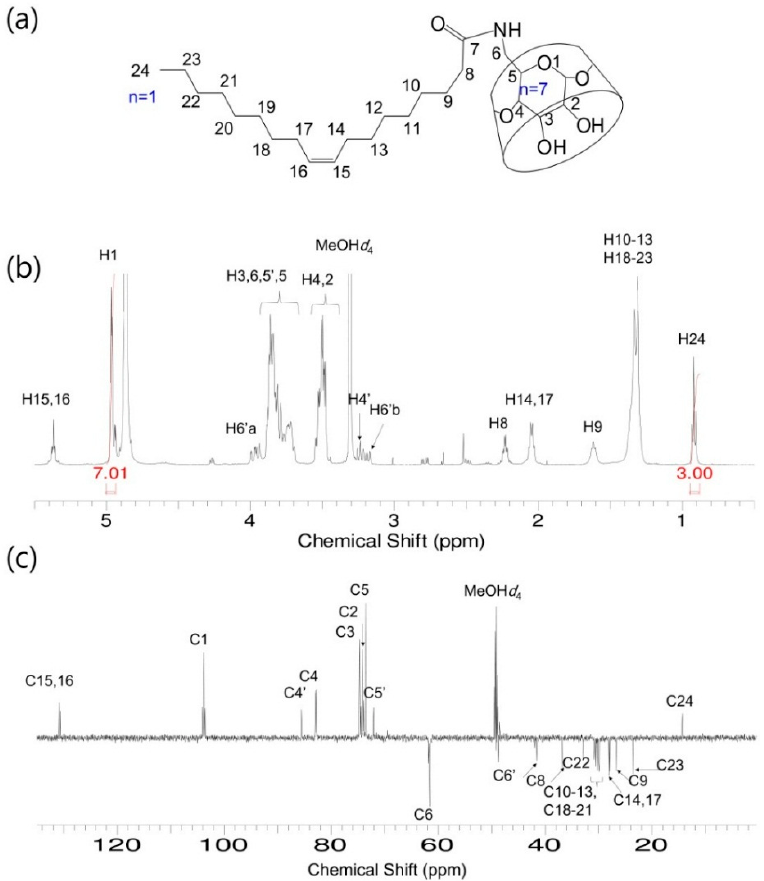
Figure 3. O- β -CD. ( a ) Chemical structure; ( b ) 1 H-NMR spectrum; and ( c ) DEPT-135 NMR spectrum. Solvent: MeOH- d 4 .